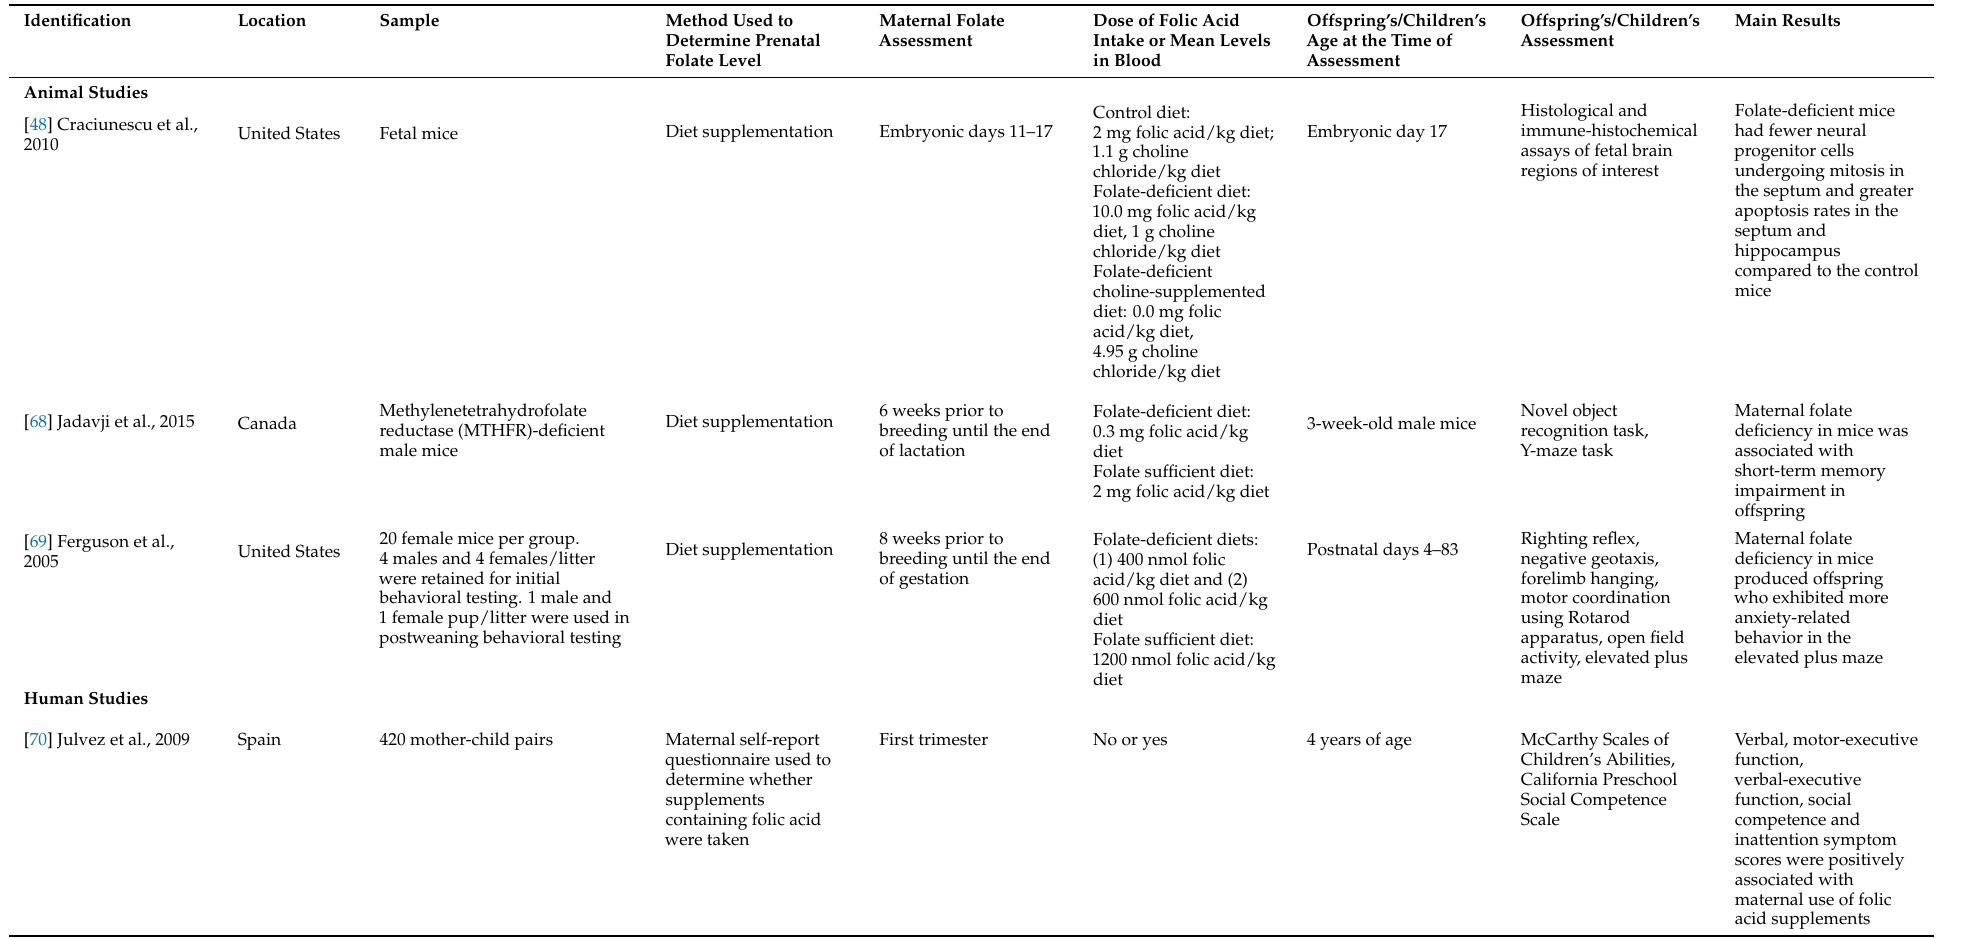
Table 1. Characteristics of the animal and human studies that examined associations between maternal prenatal folate and offspring cognitive